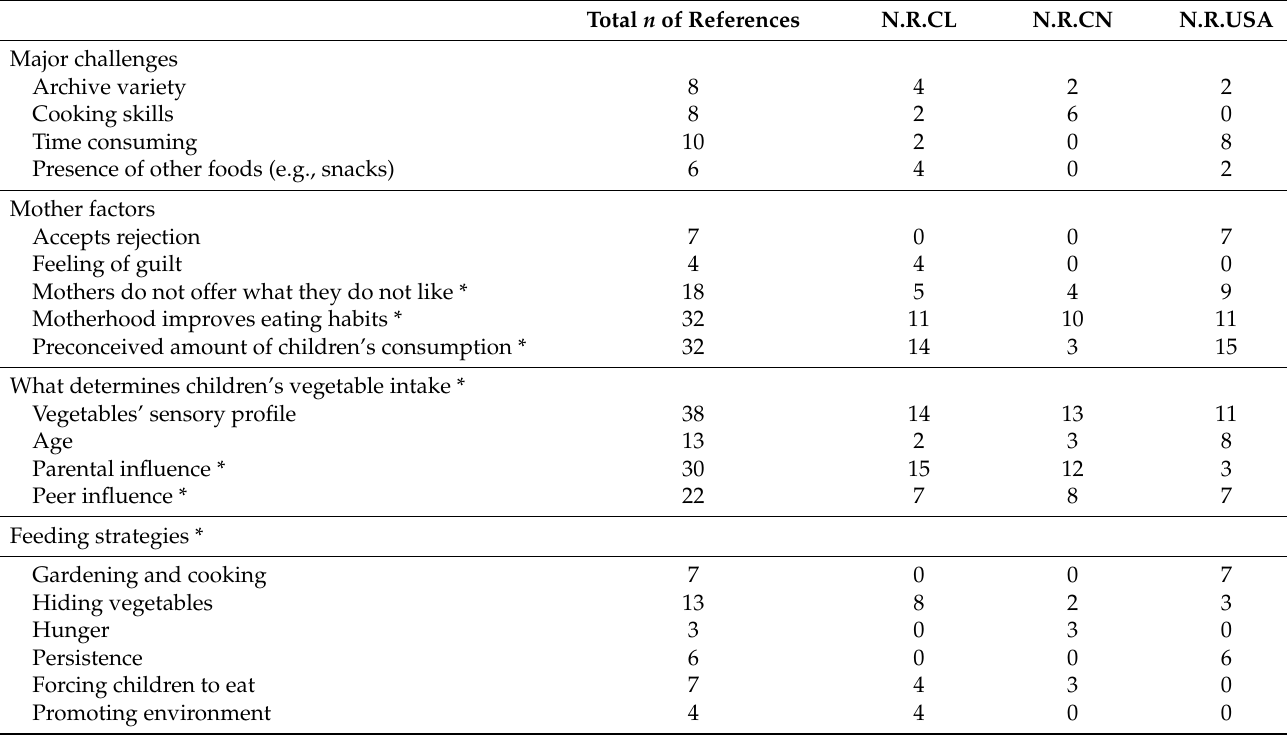
Table 3. Comparison of concepts mentioned by mothers between cultural